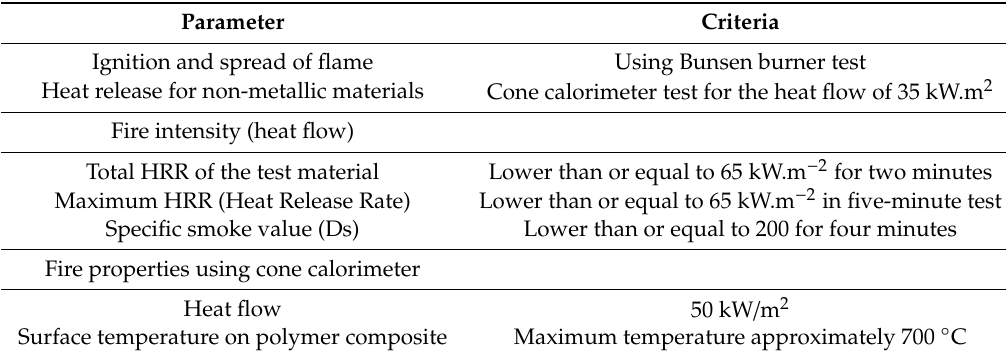
Table 1. Fire safety criteria of materials for aviation sector adjusted to the specification FAR 25.853